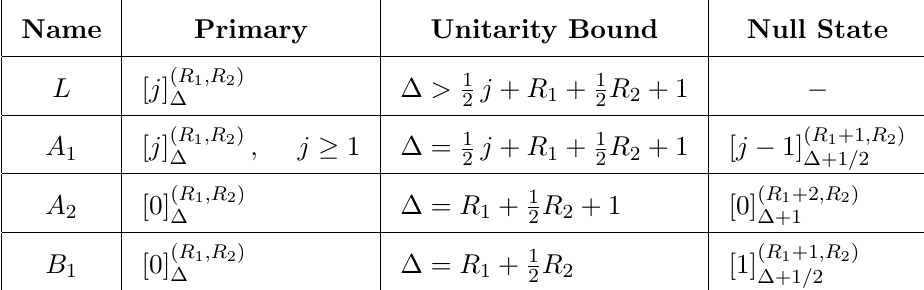
Table 7 . Shortening conditions in three-dimensional N = 5